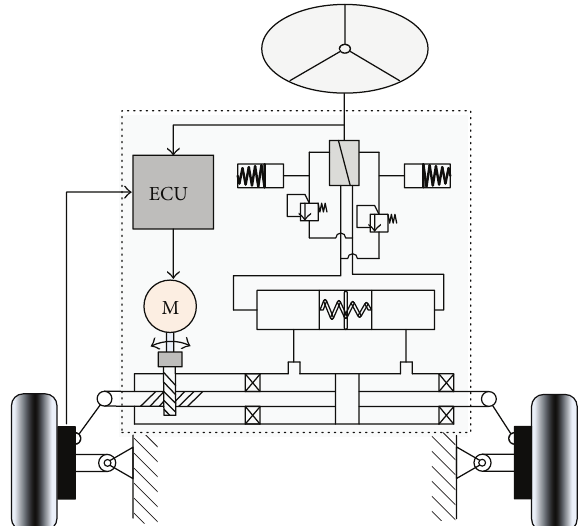
Figure 8: The improved steering-by-wire